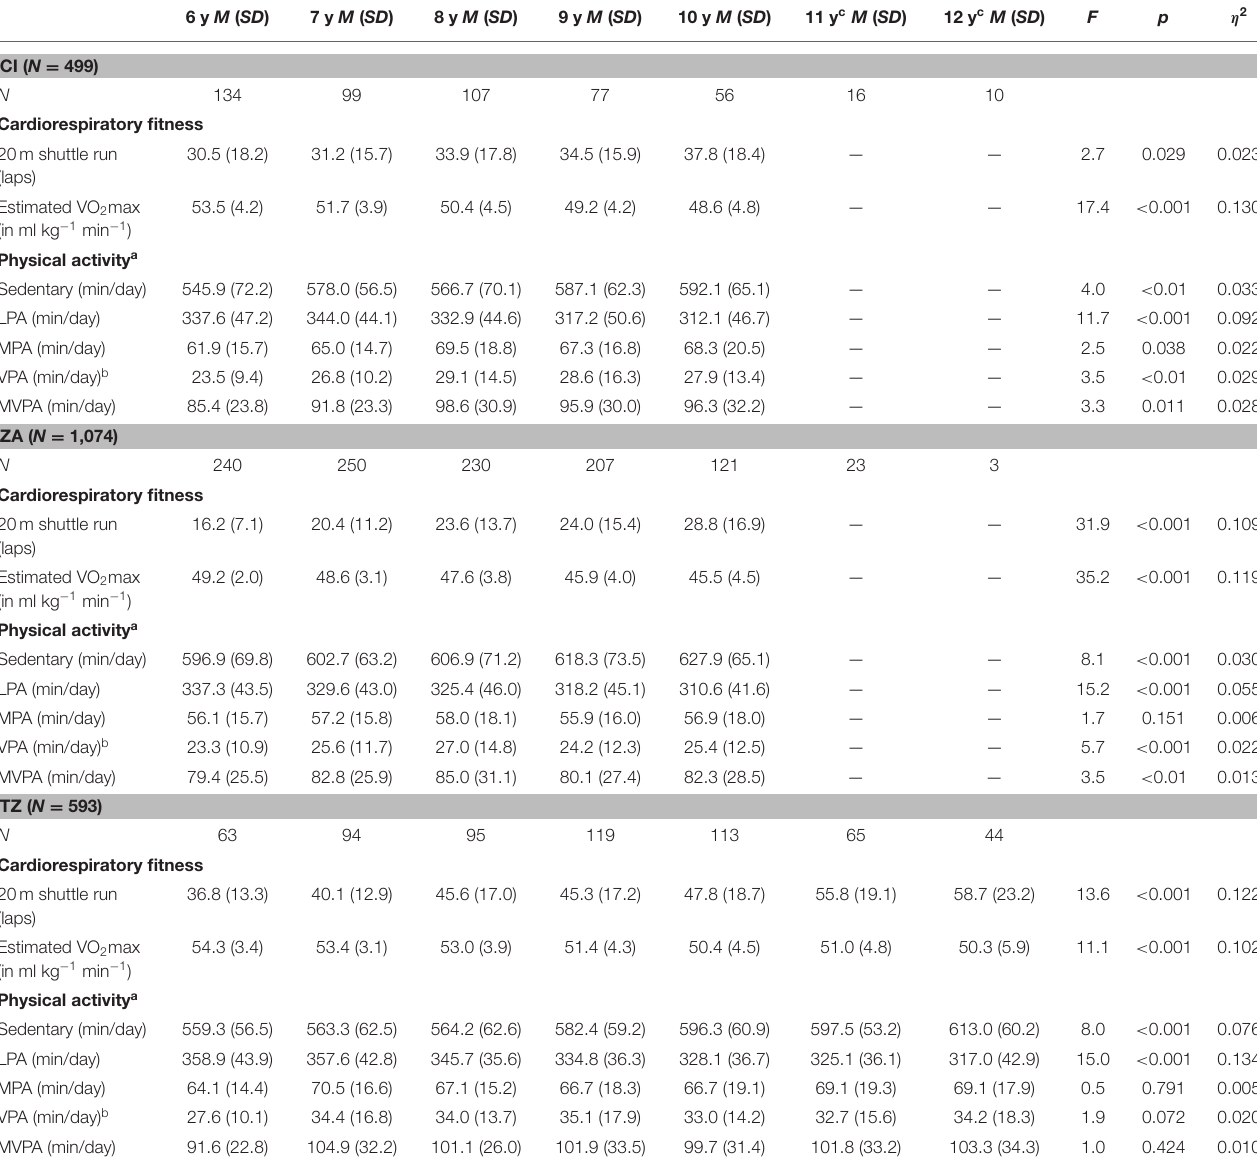
TABLE 4 | Descriptive statistics for children with different years of age, separately for children from Côte d’Ivoire (CI), South Africa (ZA), and Tanzania